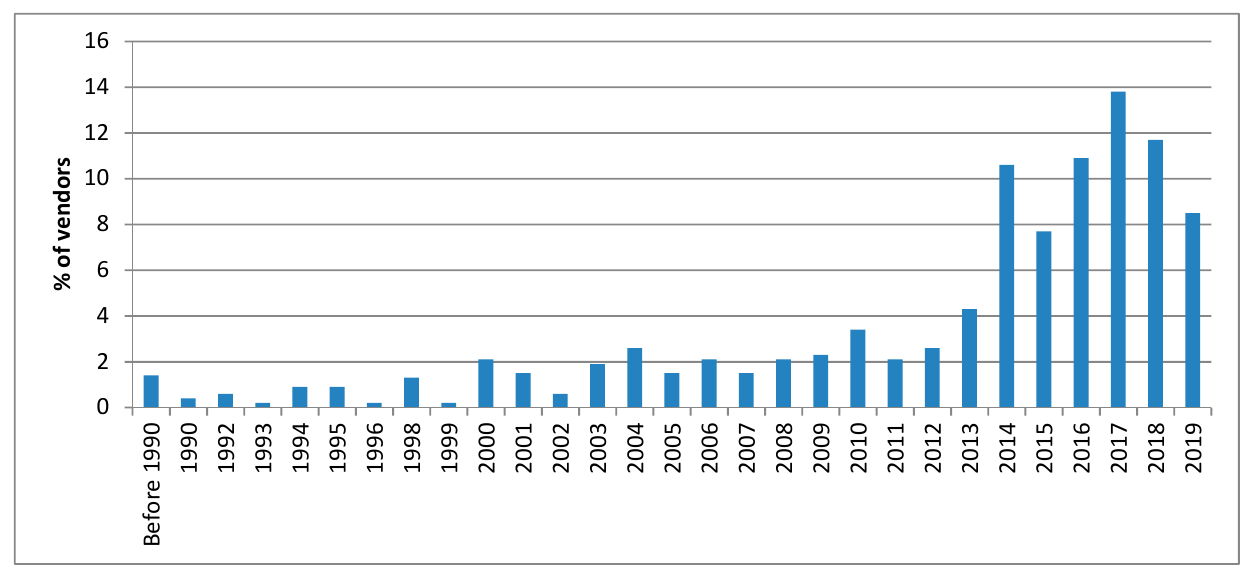
Businesses 2023 , 3 , FOR PEER REVIEW Figure 1. Startup year of food vending enterprise. Figure 1. Startup year of food vending enterprise.